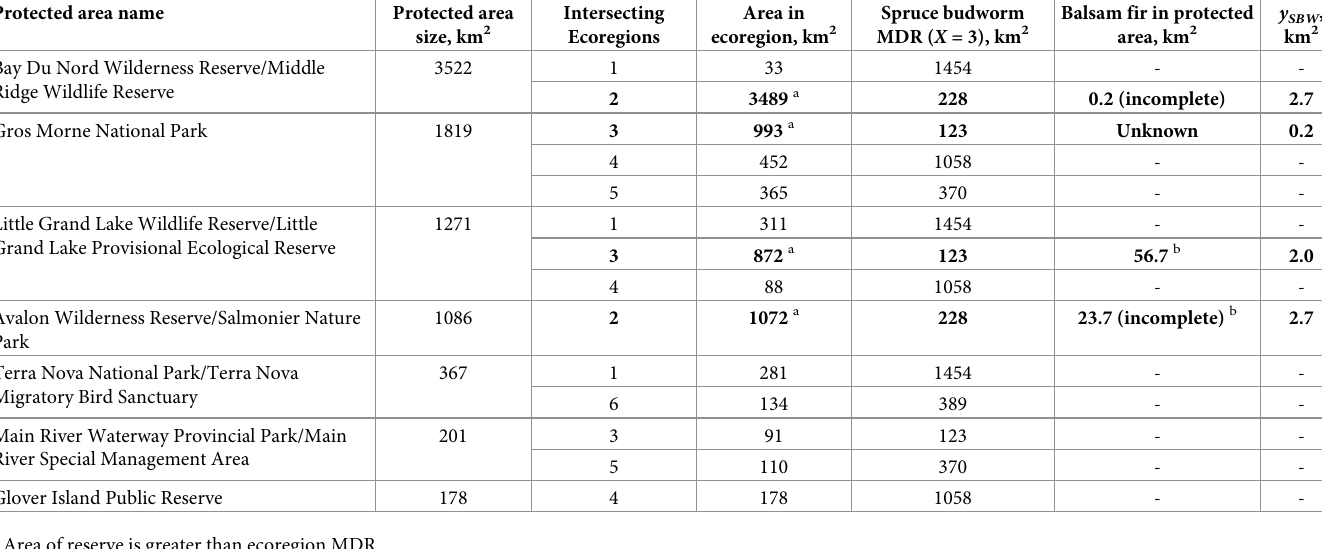
Table 2. Protected area attributes for protected areas larger than 100 km 2 in the case study region. Protected areas sharing a border were combined and clipped to the ecoregion for analysis. MDR values for ecoregions are shown for reference. Balsam fir coverage and targets ( y SBW ) are only reported for protected areas with sizes larger than the ecoregion